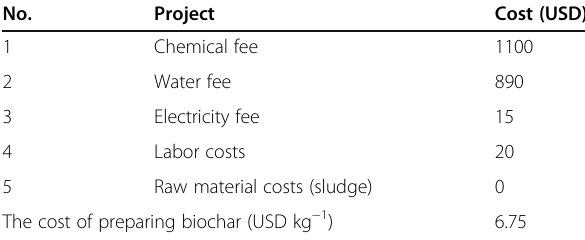
Table 5 Cost of preparing biochar